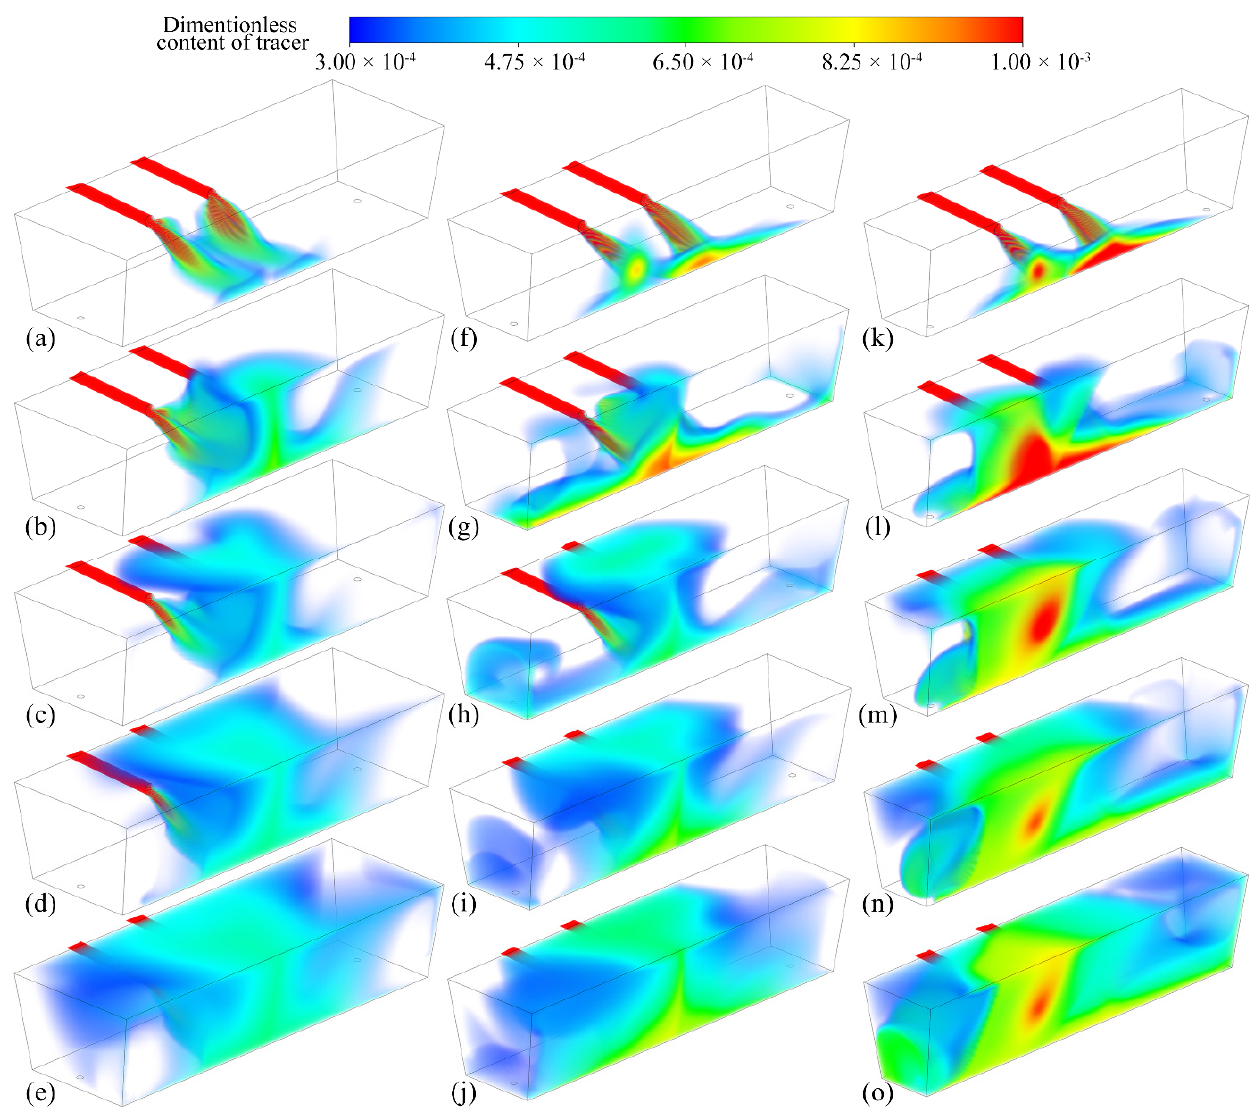
Figure 7. Transport and diffusion process of tracer in distributing chambers. ( a – e ) are distribution of tracer in distributing chamber of tundish A at 30, 45, 90, and 120 s in sequence; ( f – j ) and ( k – o ) are distribution of tracer in distributing chambers of the tundishes B and C at 30, 45, 75, and 90 s in sequence.